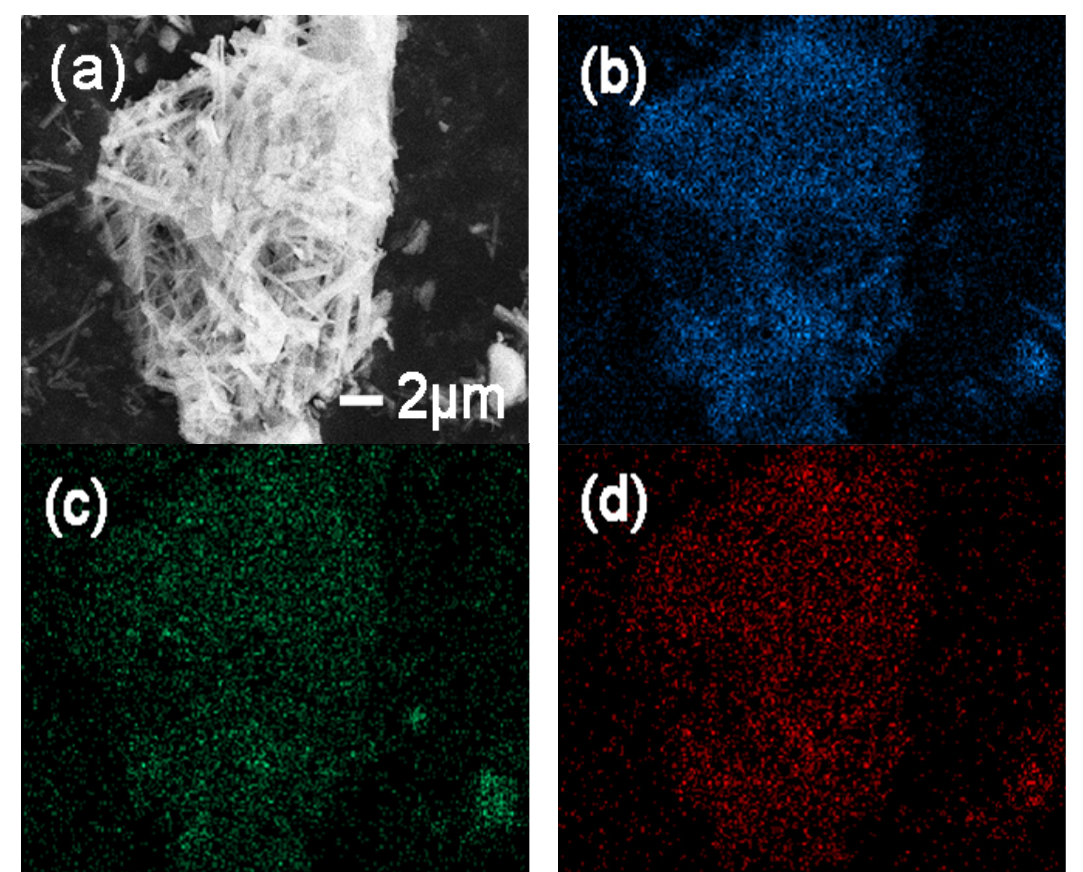
Figure 4 . SEM-EDX elemental distribution maps. ( a ) SEM image of Eu 3+ -doped nanowires; ( b ) distribution map of O; ( c ) distribution map of Si; ( d ) distribution map of Eu.